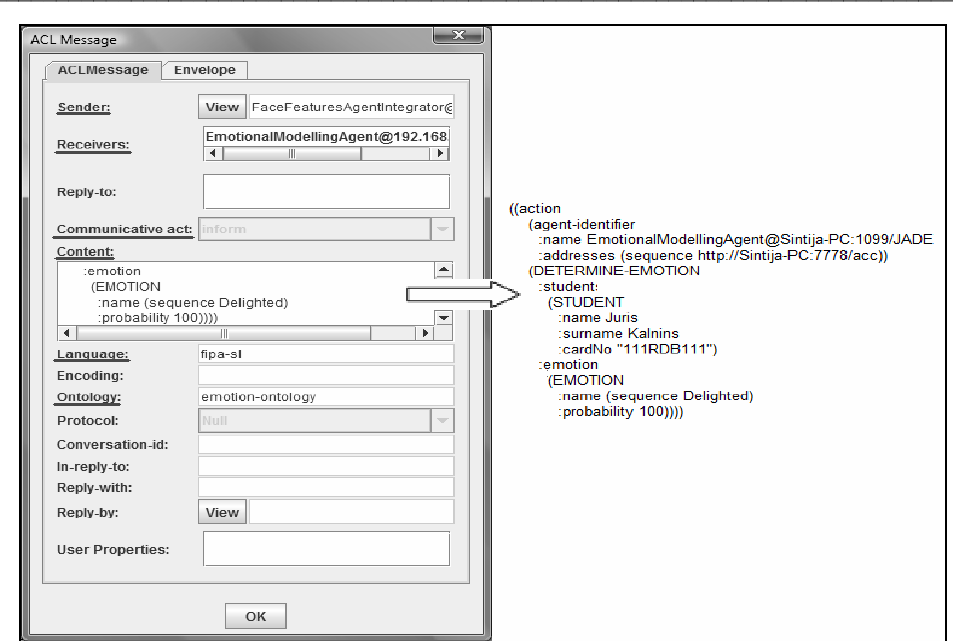
Fig. 9. Full information about the sent